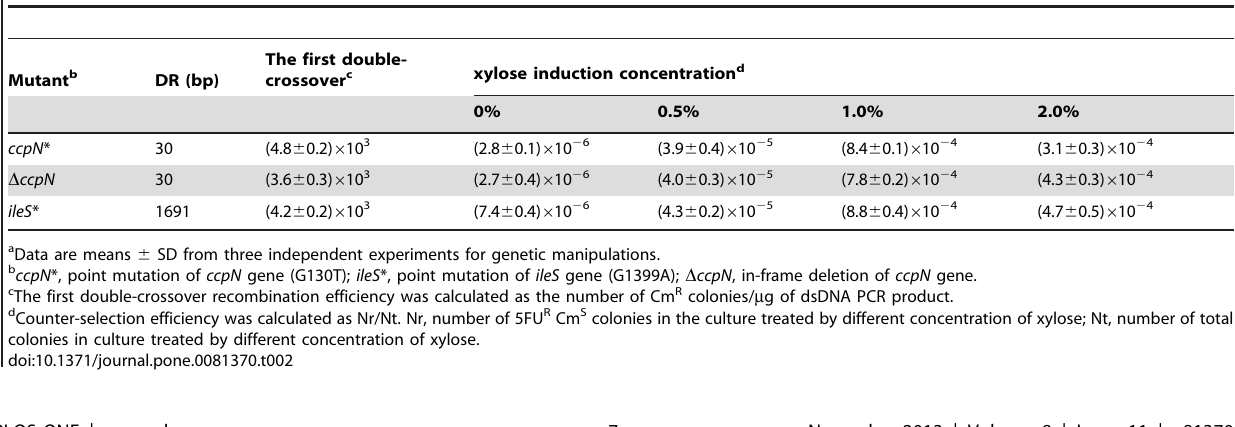
Table 2. The efficiencies of first double-crossover recombination and counter-selection a .